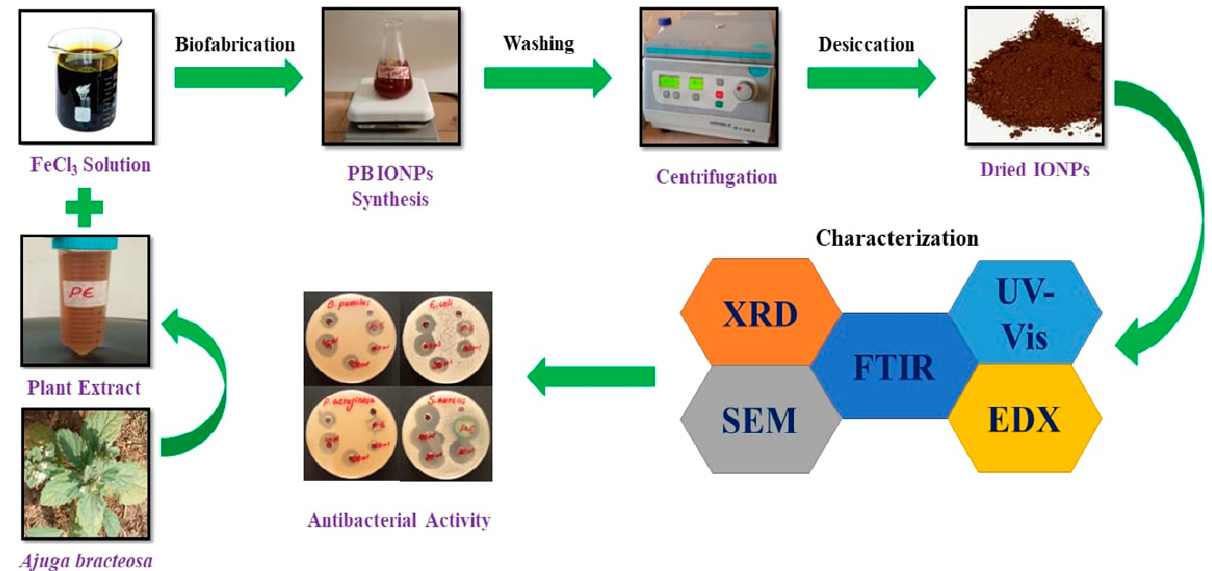
Figure 10. Green fabrication of iron oxide NPs using an aqueous extract of Ajuga bracteosa.